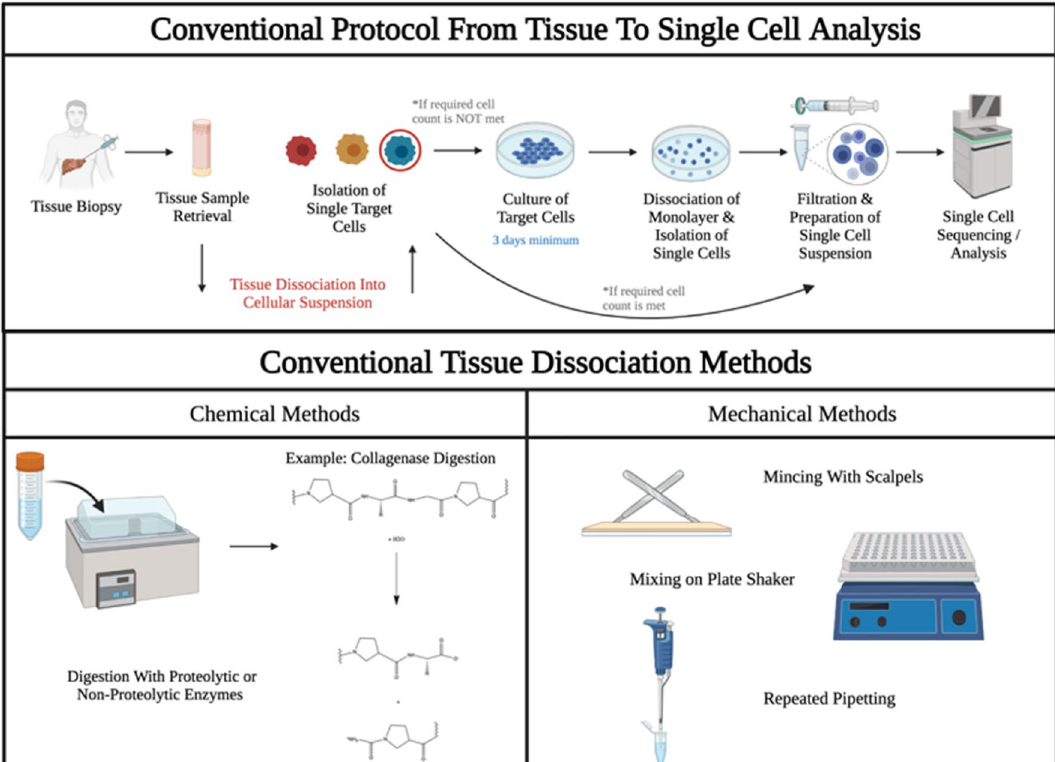
Figure 1. Overview of conventional protocol from tissue to single-cell analysis and tissue dissociation. The conventional tissue to single-cell analysis workflow is depicted, including the tissue dissociation into cellular suspension step, the focal point of this work. Post biopsy, tissue samples are recovered and subsequently dissociated, after which target cells are isolated. If baseline cell count values are not met, the cells are then cultured for a minimum of 3 days in standard protocols. In the case that the cells are cultured, the cellular monolayer is dissociated, and cells are again isolated. The cellular suspensions are then filtered of debris and doublet cells, yielding purified single-cell suspensions which can then be processed via single-cell sequencing. Traditional tissue dissociation methods highlighted here include chemical digestion with proteases, as well as mechanical mincing, mixing, and